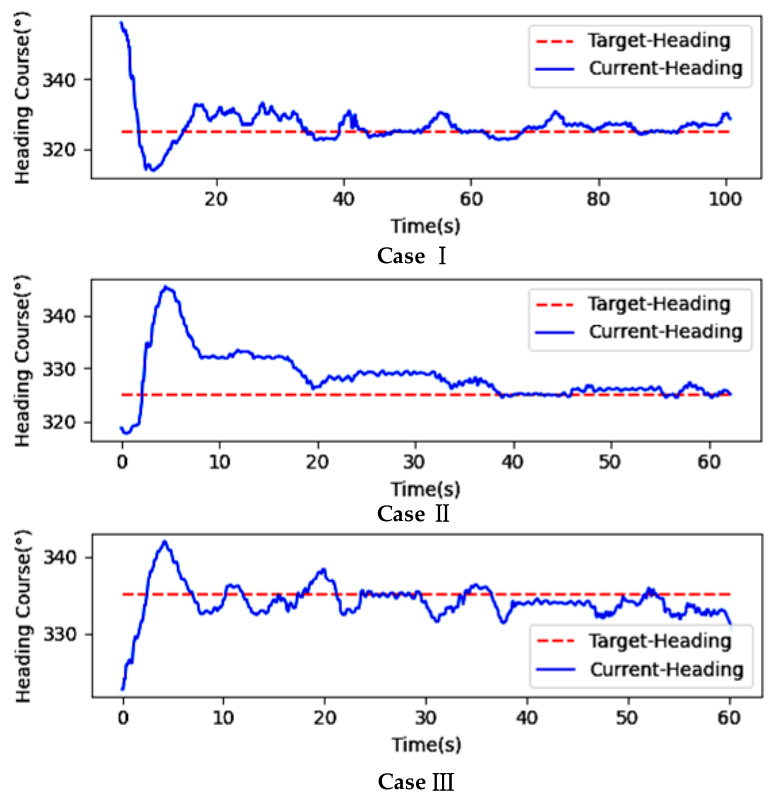
Figure 16. The change of heading angle during UUV navigation.